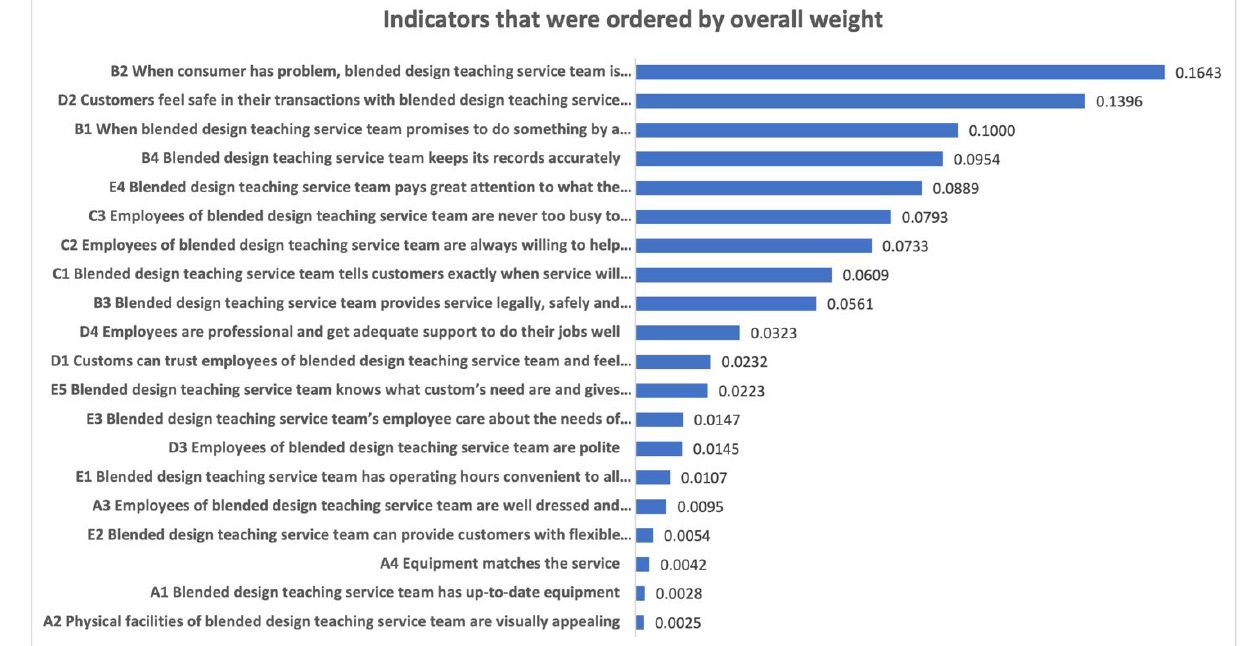
Figure 5. The overall weight and ranking of dimensions in FANP model.